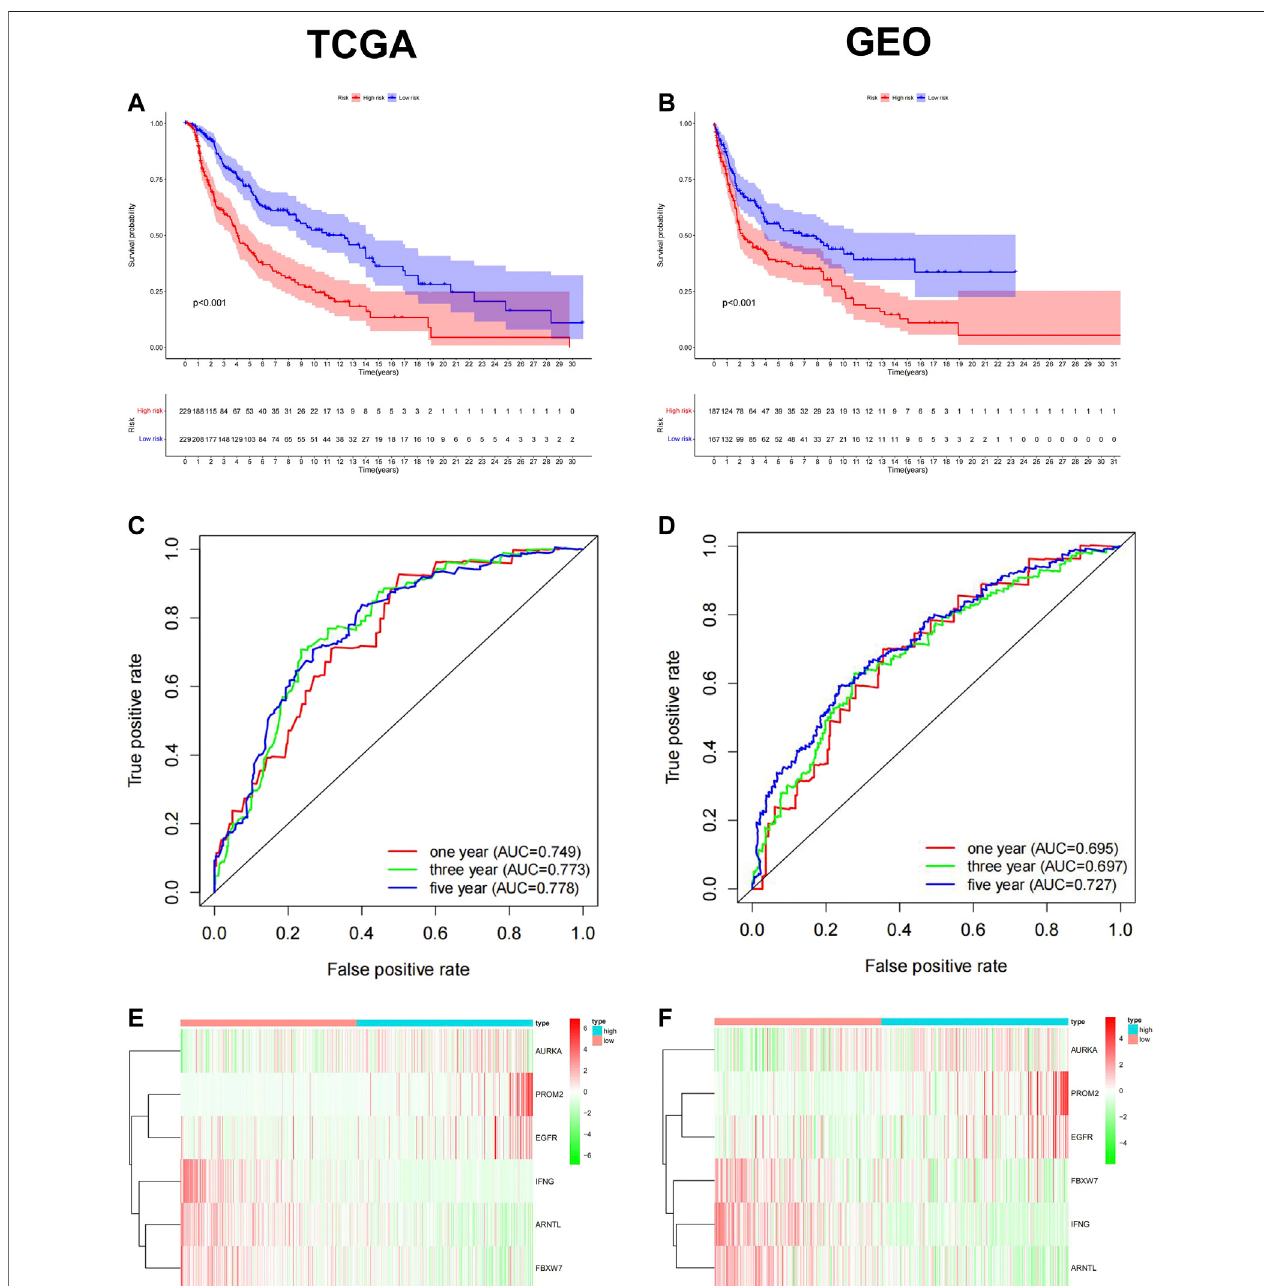
FIGURE3| Constructionandvalidationoftheferroptosis-relatedPrognosticModelinTCGAtrainingdatasetandGEOtestingdataset.Kaplan-Meiersurvivalcurve for OSinthelow-risk groupand thehigh-riskgroup, TCGA (A) and GEO (B) .TheROCcurve con fi rmedthatthehigh accuracy oftheprognostic modelinboth TCGA (C) andGEO (D) (TCGA:1 yearAUC=0.749,2 yearsAUC=0.772,3 yearsAUC=0.773;GEO:1 yearAUC=0.695,2 yearsAUC=0.747,3-yearAUC=0.697).Heatmap of the 6-FRGs expression pro fi les in the prognostic signature of melanoma in TCGA (E) and GEO (F) .